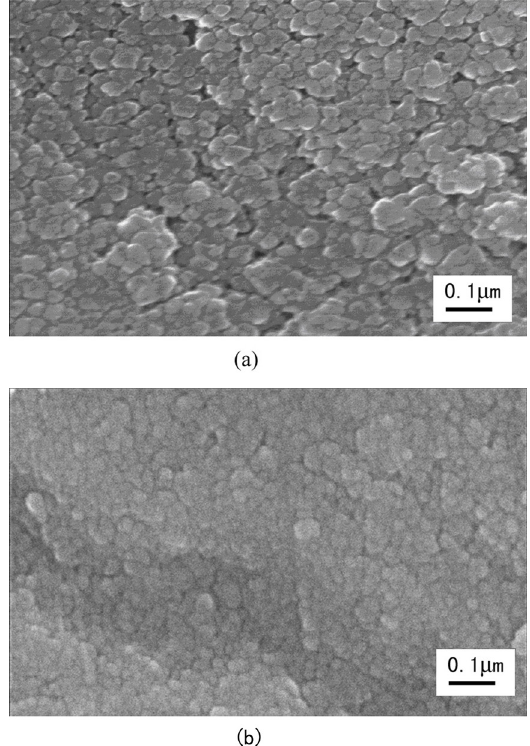
Figure 3. The surface morphology images of as-deposited films observed by SEM (a: Al film. b: TiO